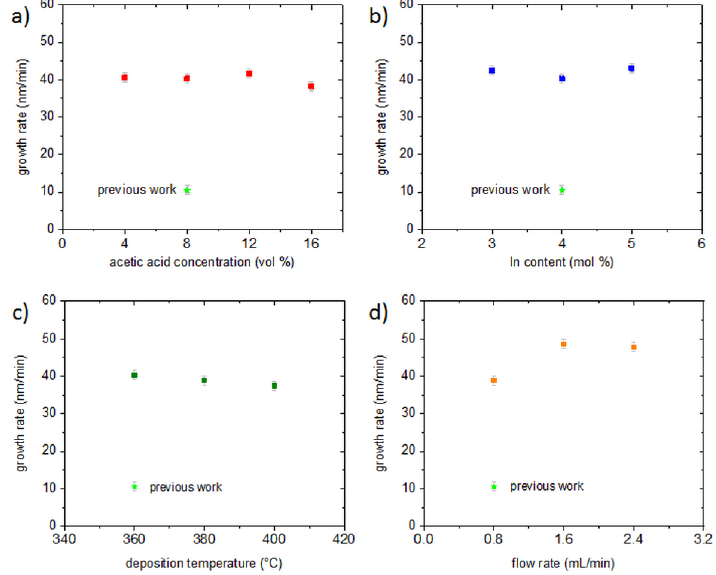
Figure 1. Film growth rate dependency on the ( a ) acetic acid concentration, ( b ) indium acetate concentration, ( c ) deposition temperature, and ( d ) flow rate compared to our previous results [8].